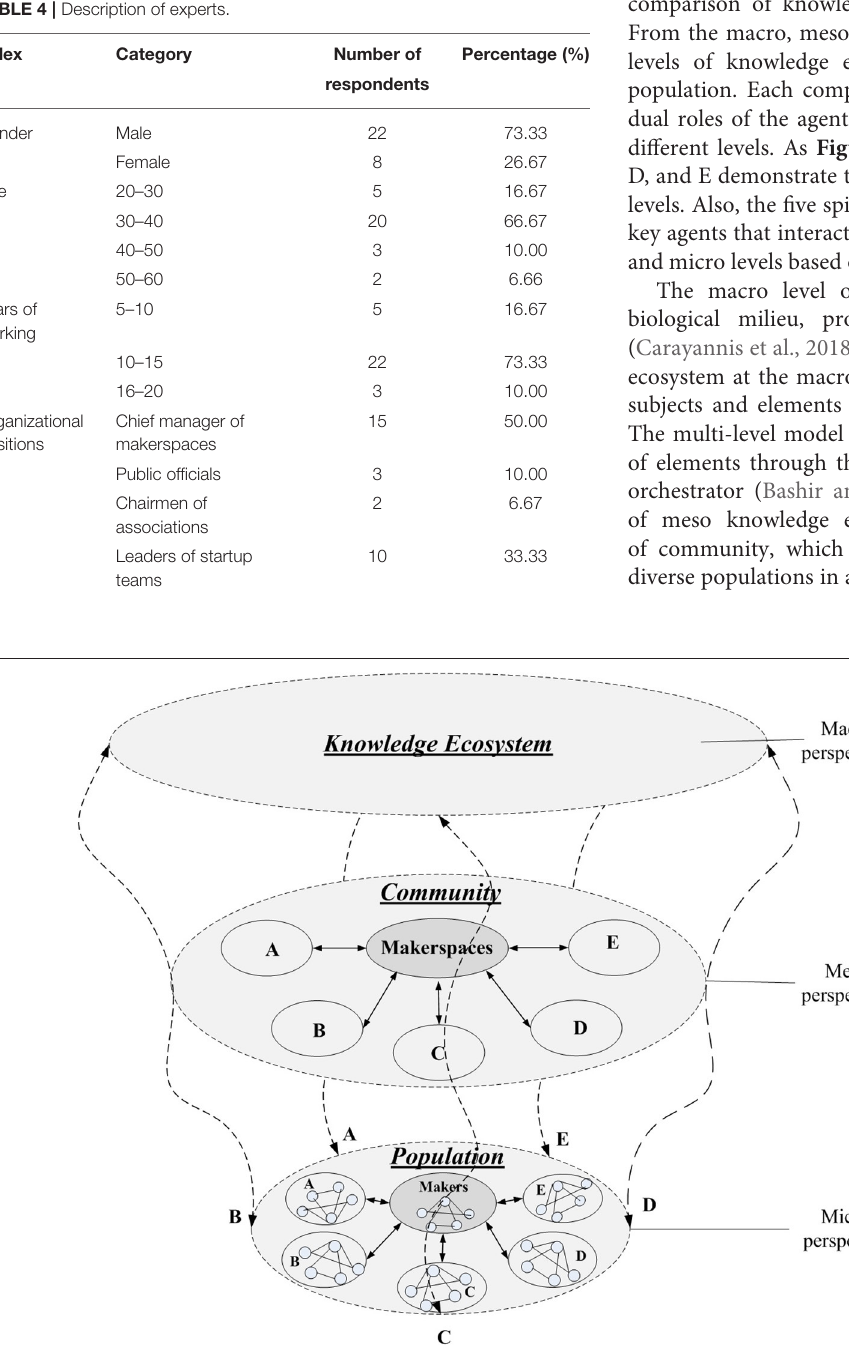
FIGURE 6 | Multi-level and multi-agent model of knowledge ecosystem (lateral